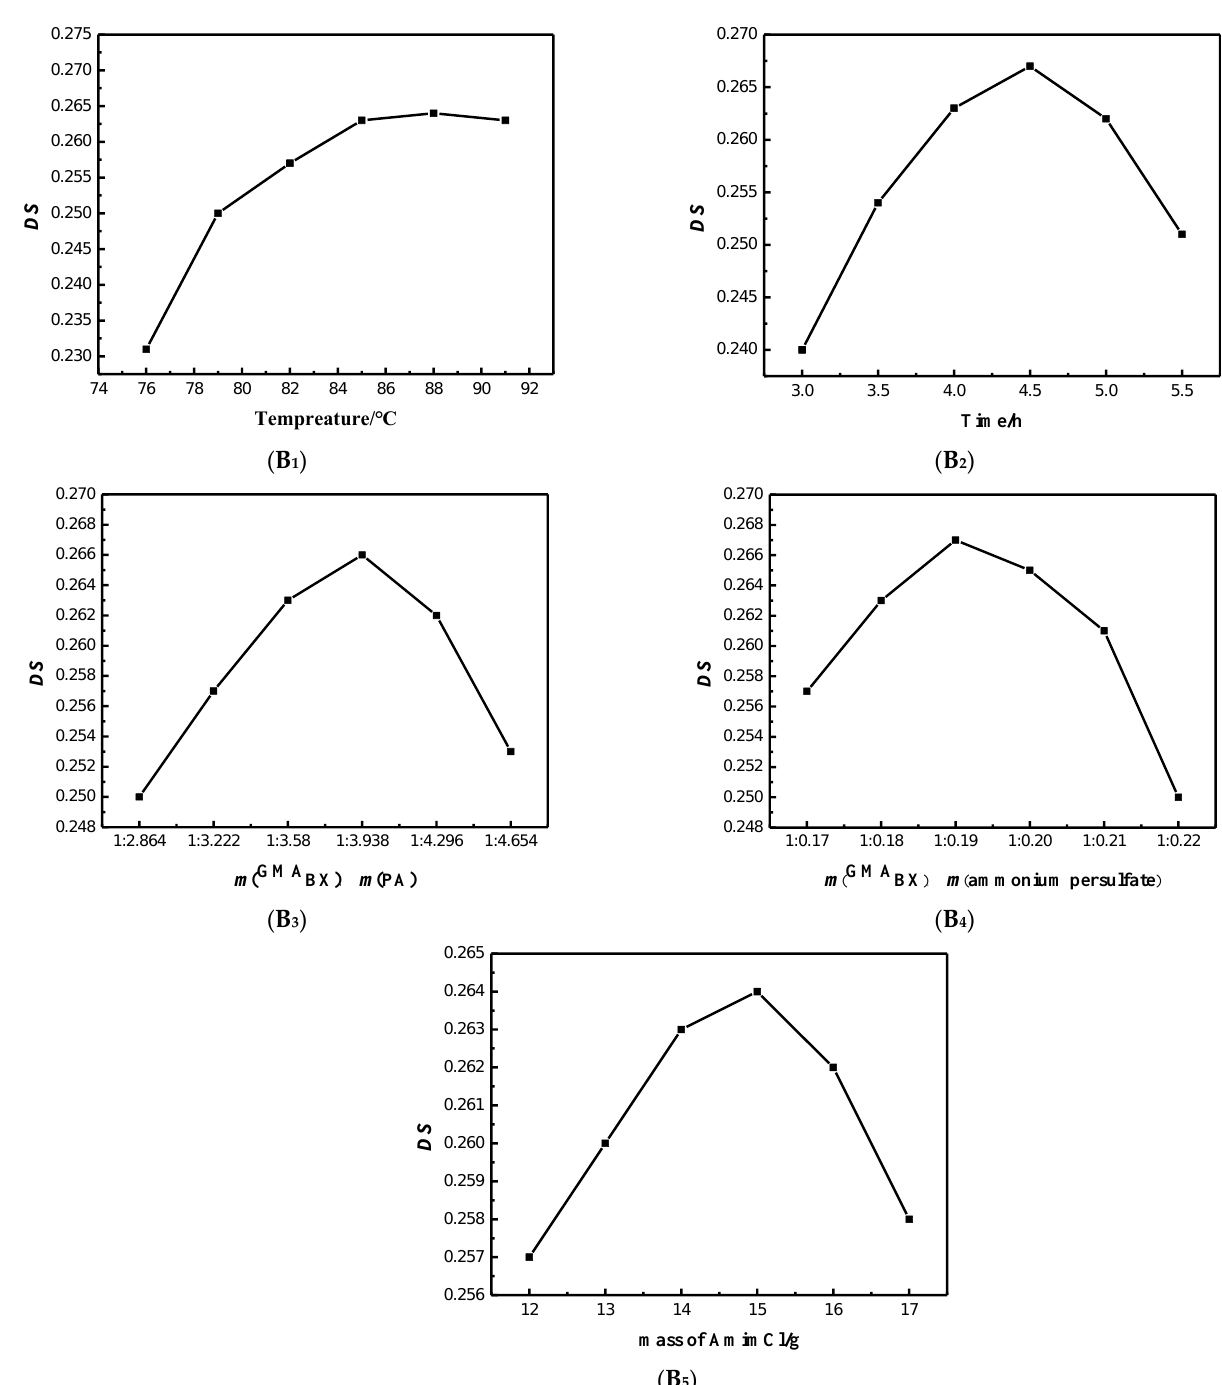
Figure 3. Effects of reaction conditions on DS . ( B 1 ) The influence of reaction temperature on DS . ( B 2 ): The influence of reaction time on DS . ( B 3 ): The influence of mass of PA on DS . ( B 4 ): The influence of mass of ammonium persulfate on DS . ( B 5 ): The influence of mass of AmimCl on DS . The influences of B 1 , B 2 , B 3 , B 4 and B 5 were examined by keeping the other four factors constant.